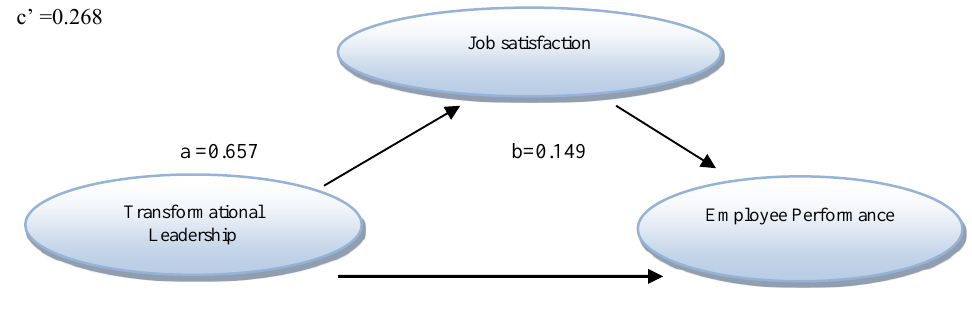
Figure 3: Mediation of Jobs